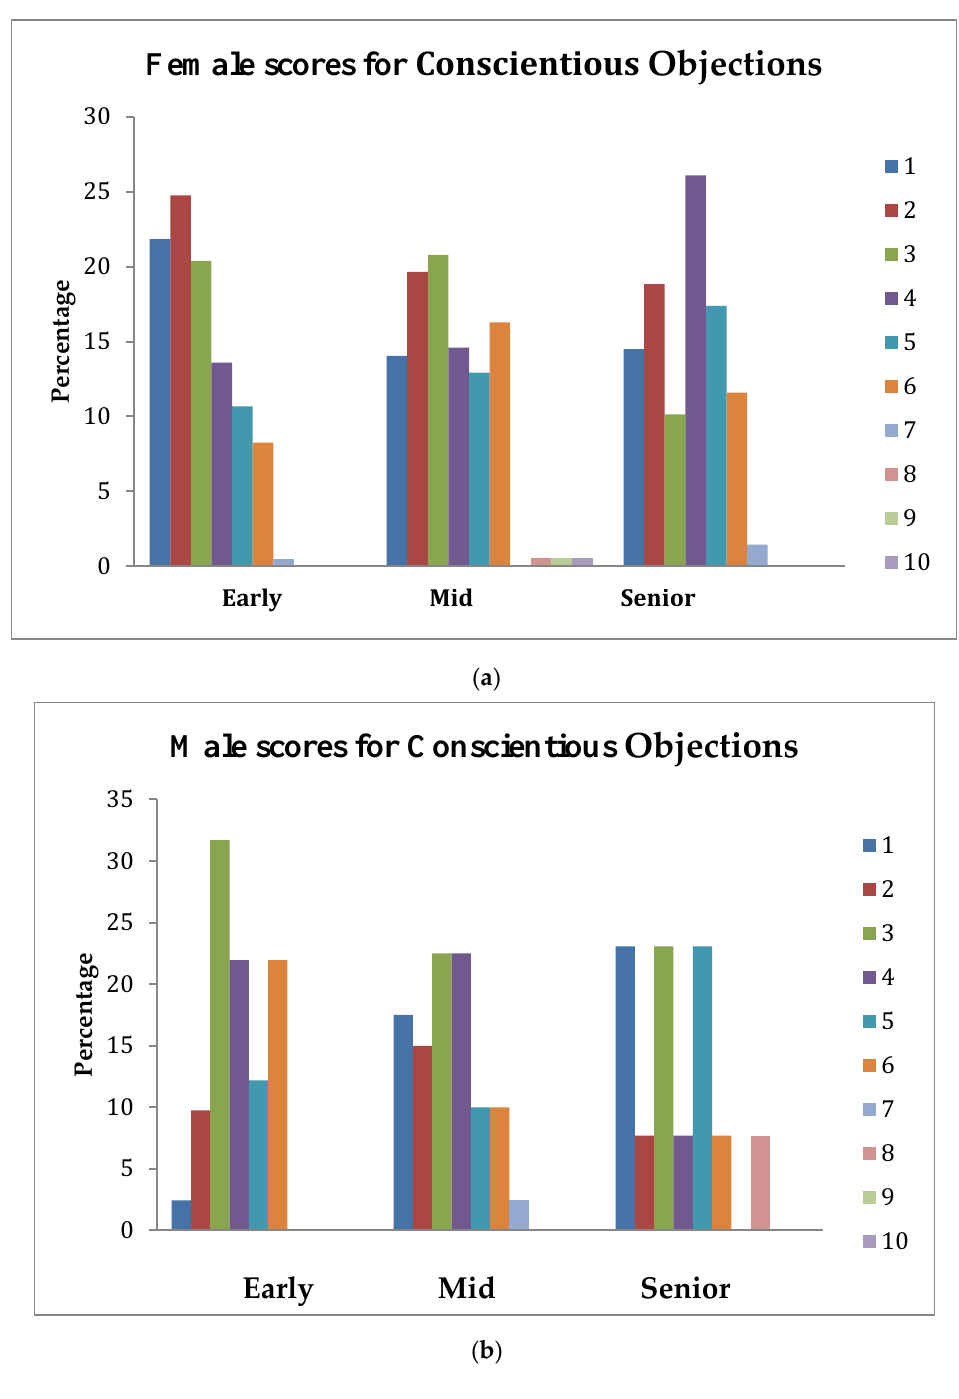
Figure 3. ( a ) Percentage of female students across stage-of-study rating the importance (1 = extremely